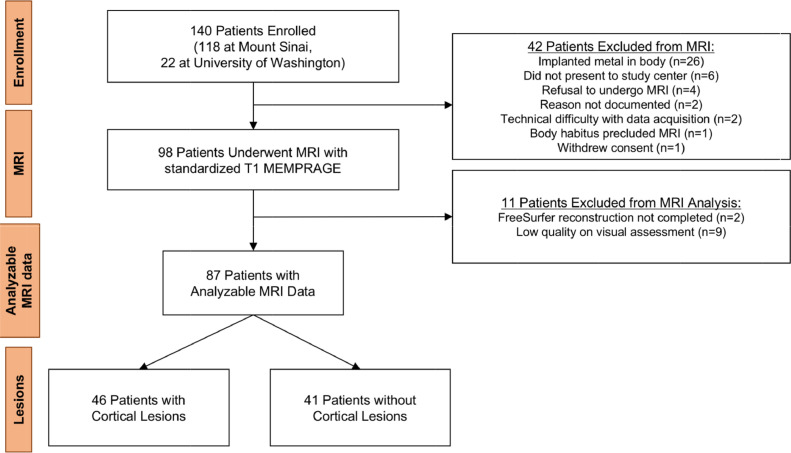
CONSORT Diagram.